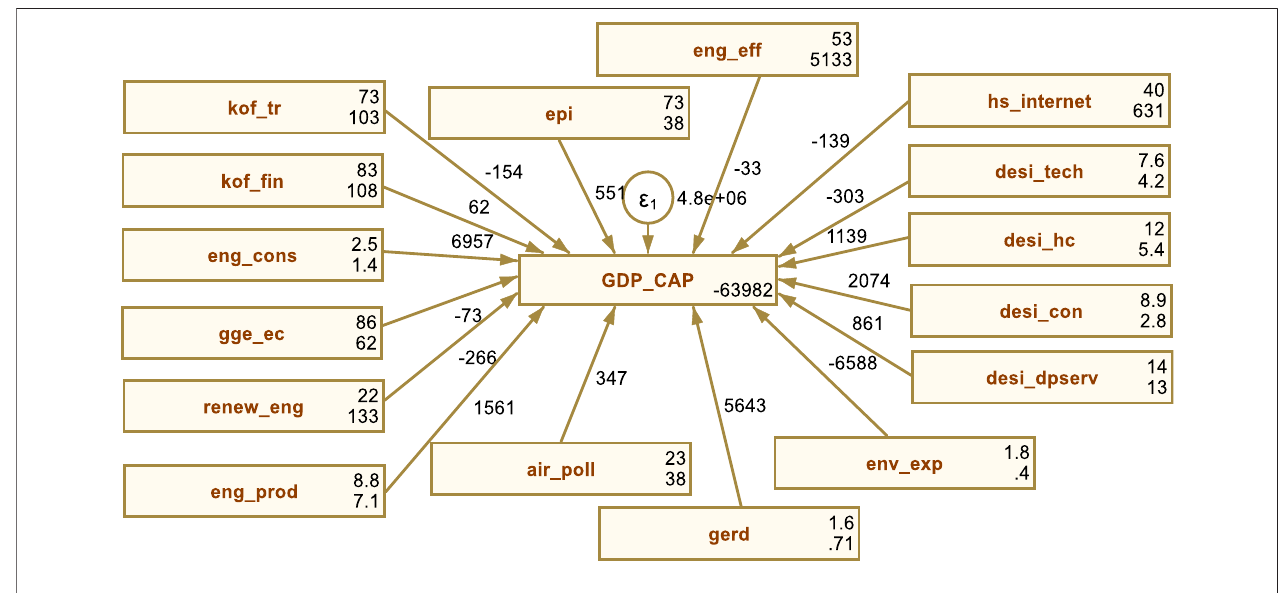
FIGURE 2 | | Results of SEM for the EU-27 MS. Source: Authors ’ research.